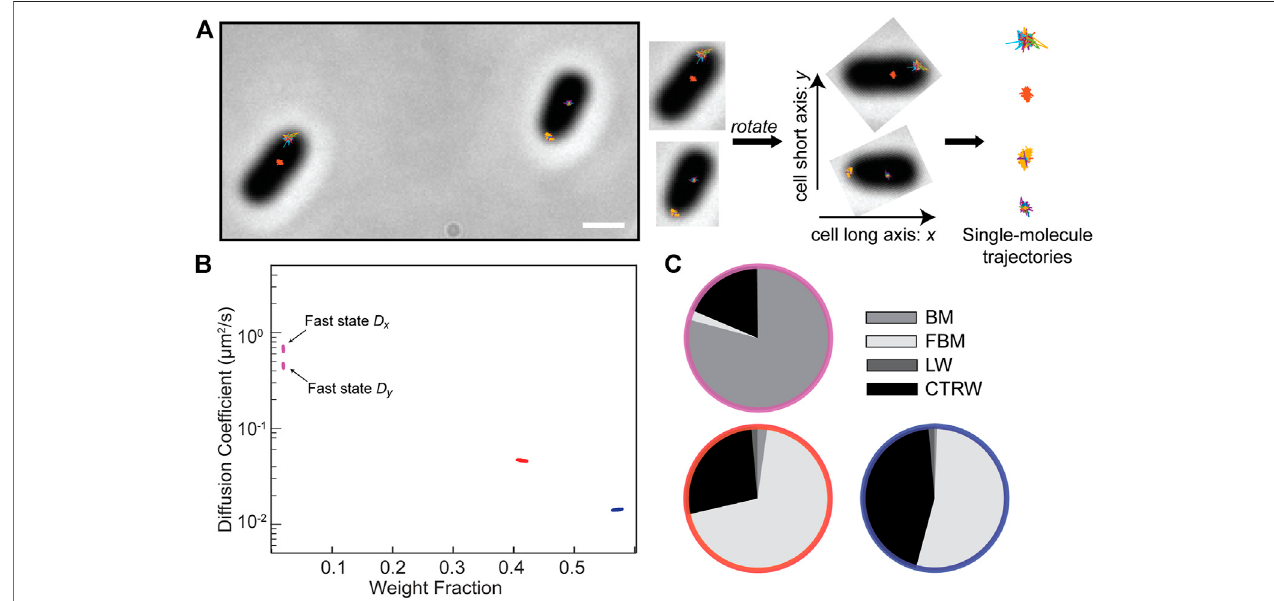
FIGURE 4 | Application of NOBIAS to single-molecule trajectories of the SusG protein in living Bacteroides thetaiotaomicron cells. (A) Single-molecule trajectories of SusG-HaloTag overlaid on the phase-contrast image of the corresponding B. thetaiotaomicron cells, scale bar: 1 μ m. The long axis of the phase mask for each cell was detected and a rotation transform was applied to all the trajectories in each cell such that the x -axis is the cell long axis for all cells. (B) The NOBIAS HDP-HMM module identi fi es three diffusive states for SusG (colored clusters). Each point represents the average apparent singlemolecule diffusion coef fi cient vs. weight fractionineachdistinctmobilitystateat eachiteration oftheBayesian algorithmsavedafter convergence. Theblue andredpointsclustersaveragethe x -and y -diffusion coef fi cients as they are symmetric (Supplementary Table S4); the asymmetric fast state (purple) shows a different D x and D y . (C) The NOBIAS-RNN determines the probability thatthe diffusion type for each diffusivestate in (B) isclassi fi ed asBrownian Motion(BM), Fractional Brownian Motion(FBM), ContinuousTime Random Walk (CTRW), or Lévy Walk (LW). The color of each pie chart indicates the diffusive state corresponding to the color in (B) . The fast state (purple) is predicted with high probability to be BM; the two slower states (red and blue) are predicted to be FBM or